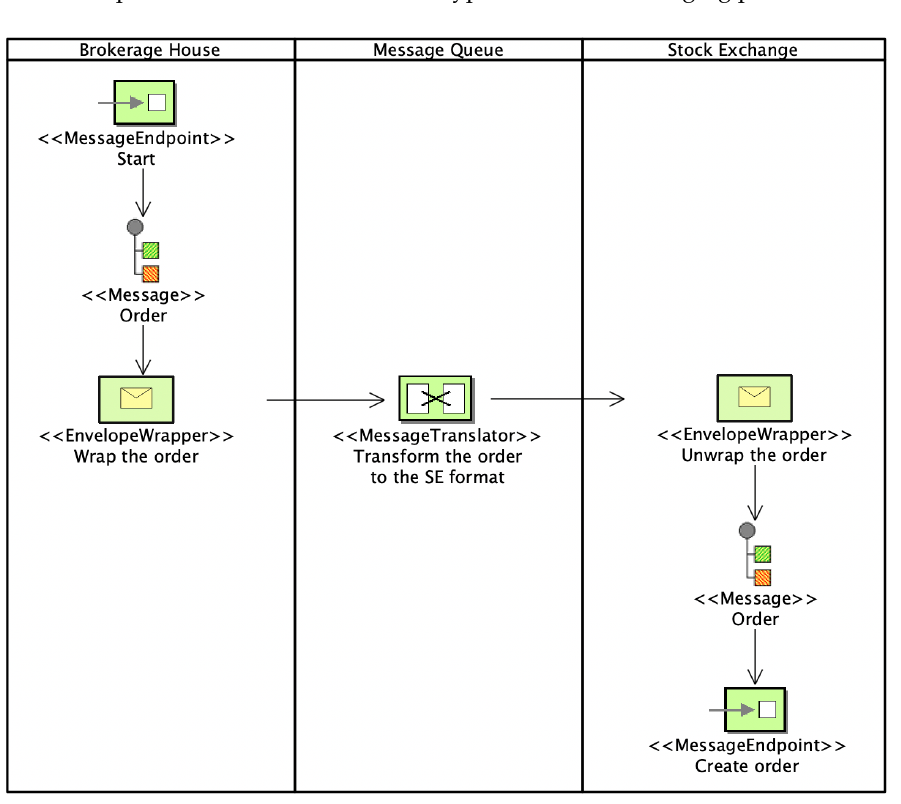
Figure 6. The Send order to the Stock Exchange integration